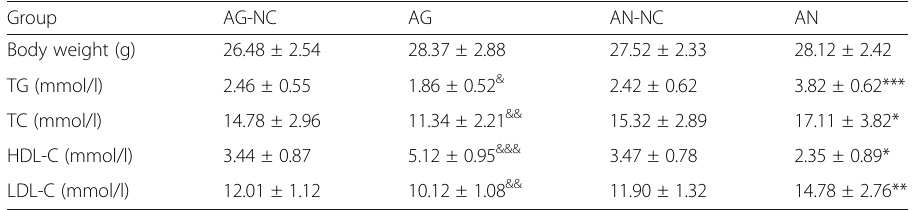
n =10; AG-NC miR-637 agomir negative control; AG miR-637 agomir, AN-NC miR-637 antagomir negative control, AN miR- 637 antagomir, TG Triglyceride, TC Total cholesterol, HDL-C High density lipoprotein cholesterol, LDL-C Low density lipoprotein cholesterol & , && and &&&& respectively indicate p <0.05, p <0.01 and p <0.001 *, ** and *** respectively indicate p <0.05, p <0.01 and p